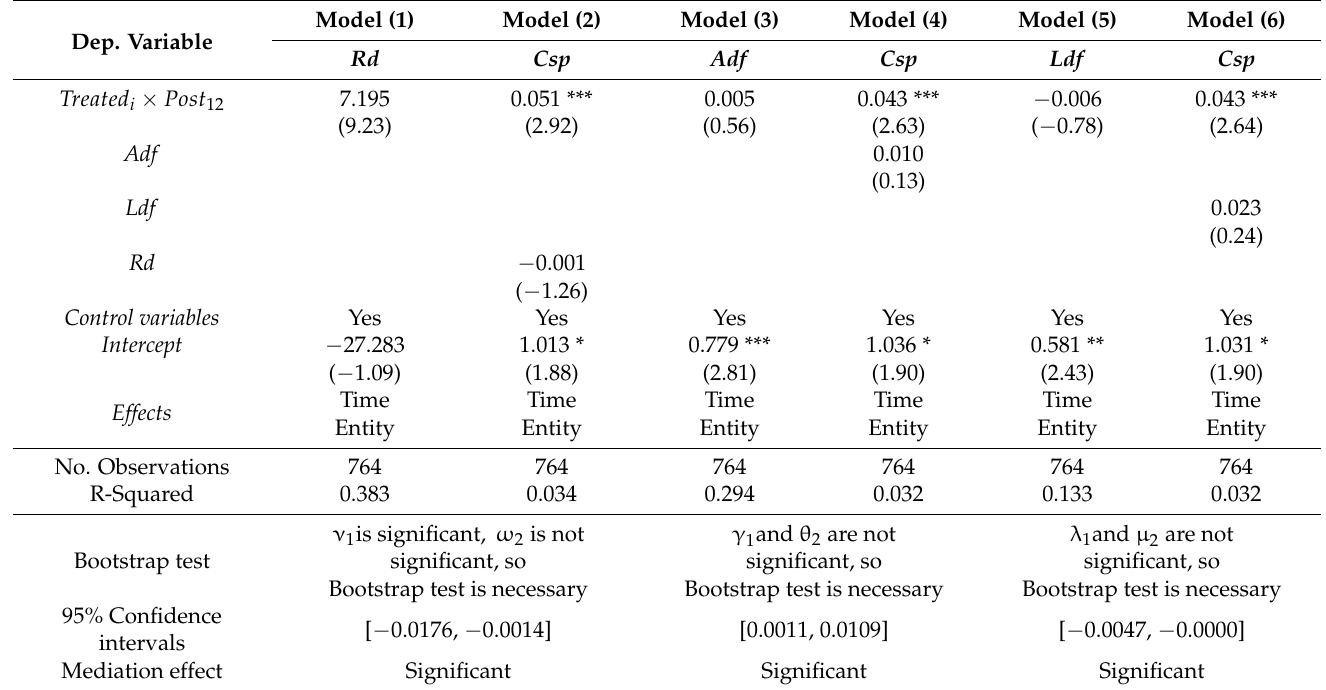
Table 7. The mediating effect of credit resource allocation and technological innovation